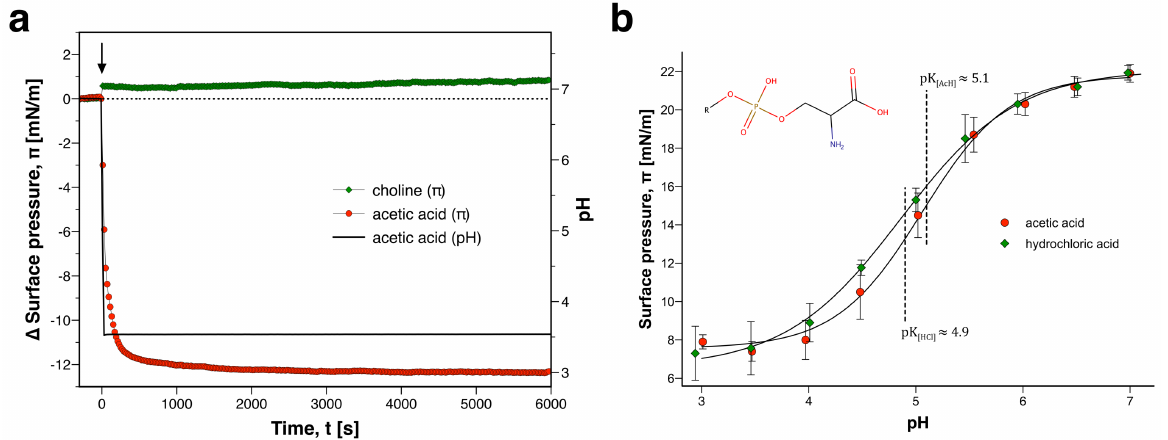
Figure 3. Control experiments with hydrolysis products of ACh. ( a ) Surface pressure change upon injection of choline (green diamonds) or acetic acid (red circles) onto a DMPS monolayer. Each data series is a representative example taken from a set of n = 5 measurements. ( b ) Three protons can dissociate from the headgroup of phosphatidylserine (PS). Titrations with acetic acid (red circles) or hydrochloric acid (green diamonds) reveal the strong membrane state changes at pK COOH . Solid lines represent fits of Boltzmann sigmoid functions. Each data series consists of mean values ± StDev of n = 3–4